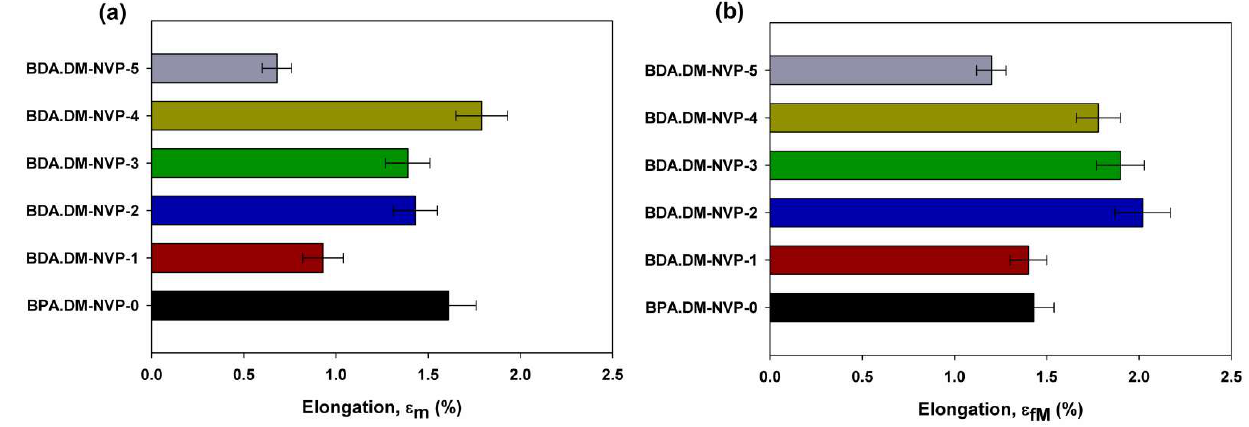
Figure 10. Elongation diagram during tensile ( a ) and bending ( b ) tests.